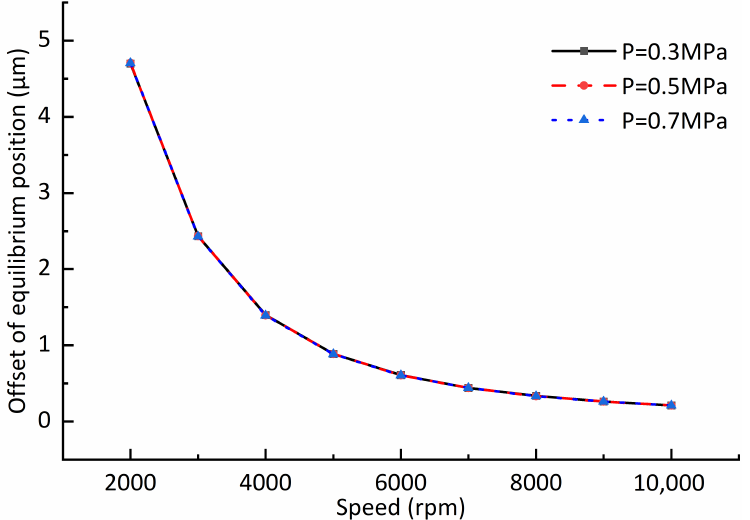
Figure 9. Offsets of static equilibrium position under different pressures and rotating